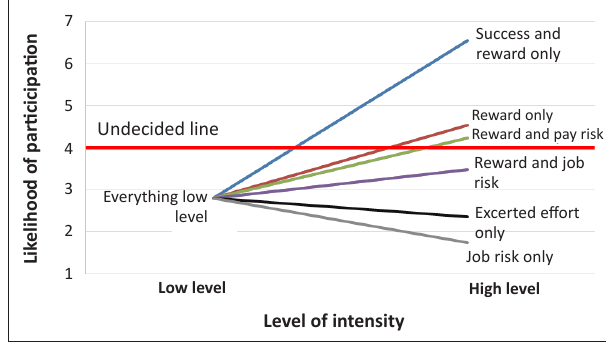
FIGURE 3: Likelihood of corporate entrepreneurship participation based on level of intensity.